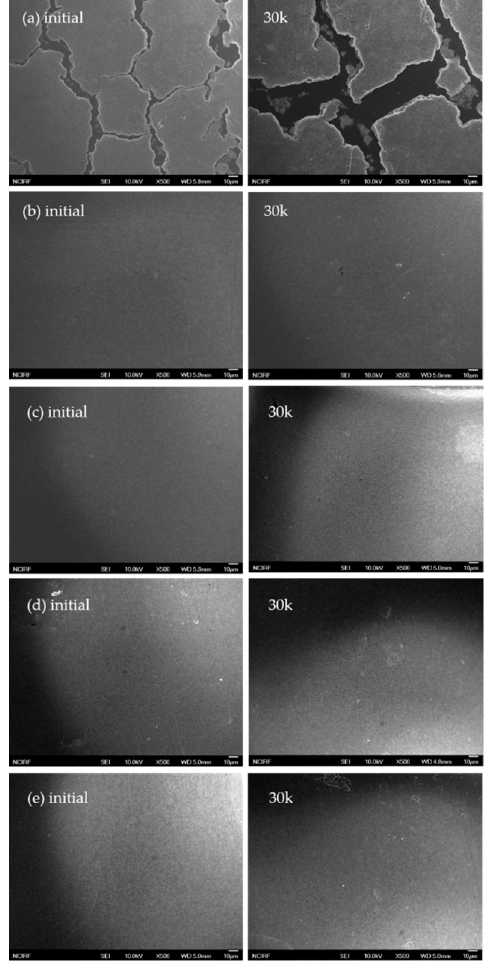
Figure 5. Scanning electron microscope ( SEM) images of the surface of CCMs prepared from: ( a ) 2.5 wt.% water–IPA; ( b ) 2.5 wt.% NMP; ( c ) 2.5 wt.% water–IPA+2.5 wt.% NMP; ( d ) 5 wt.% water–IPA+adding NMP; and ( e ) 5 wt.% NMP+adding water–IPA dispersions, both initially and after 30k